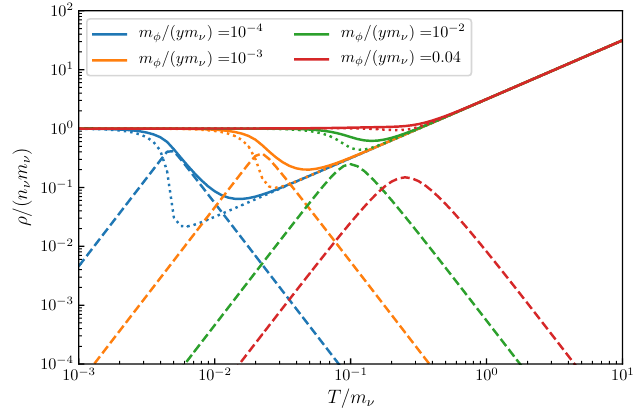
Figure 7 . Dependence of comoving energy densities on T/m ν for different values of m φ / ( ym ν ) . The dashed lines corresponds to the energy of the scalar field, the dotted lines to the energy of neutrinos, and the solid lines to the total